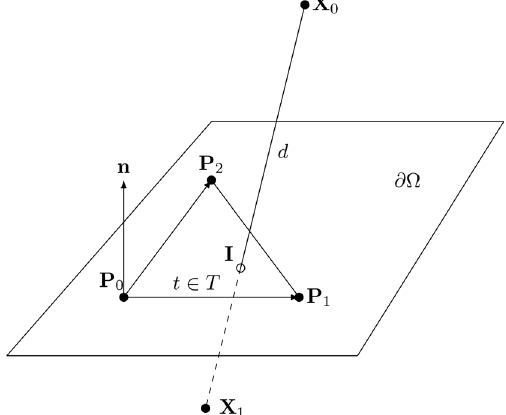
FIG. 4. The boundary ∂ Ω is discretized by a set of triangles T . Shown is the line segment/triangle intersection test with the line segment ð X 0 ; X 1 Þ , the triangle t ∈ T and the intersection at I ∈ ∂ Ω .